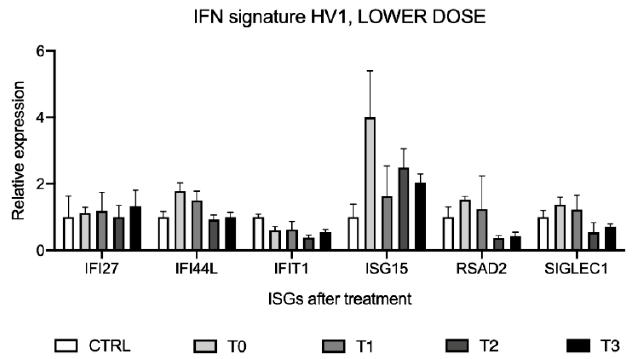
Figure 7. Interferon signature analysis after sulforaphane (SFN) supplement assumption in the first volunteer (HV1) displayed as the expression levels of the six interferon-stimulated genes (ISGs). Data are shown as means and C.I. of one representative experiment reported evaluating 2 −ΔΔ Ct values considering a pool of healthy volunteers’ cDNAs as calibrator and using HPRT1 and G6DP housekeeping genes as reference.